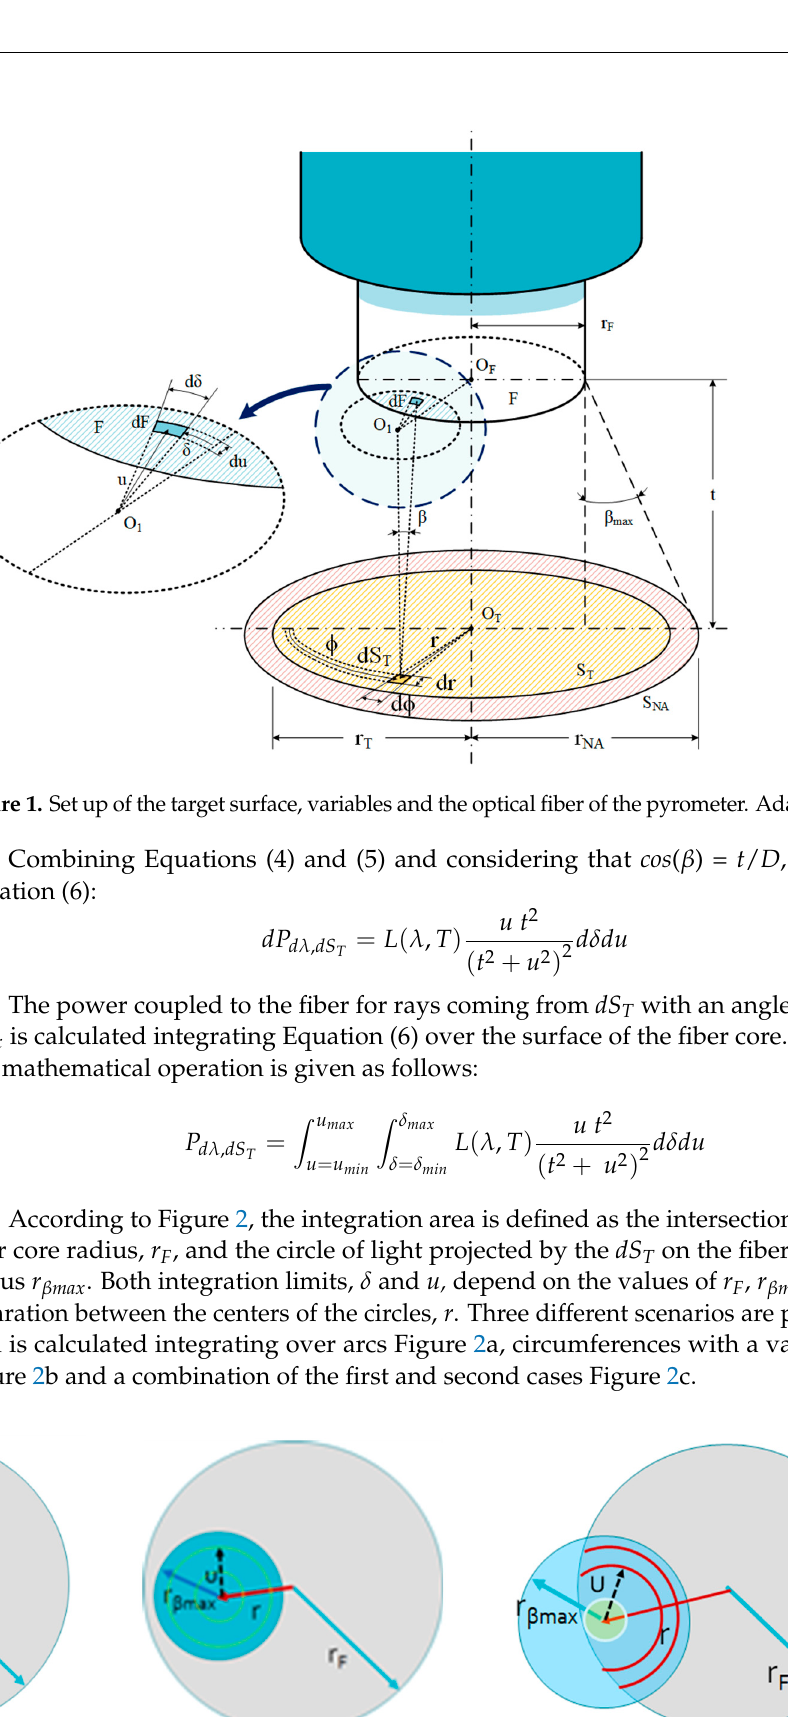
Table 1. Integration limits of u according to the ratio between r β max and r F for different values of r. r Case I r β max < r F